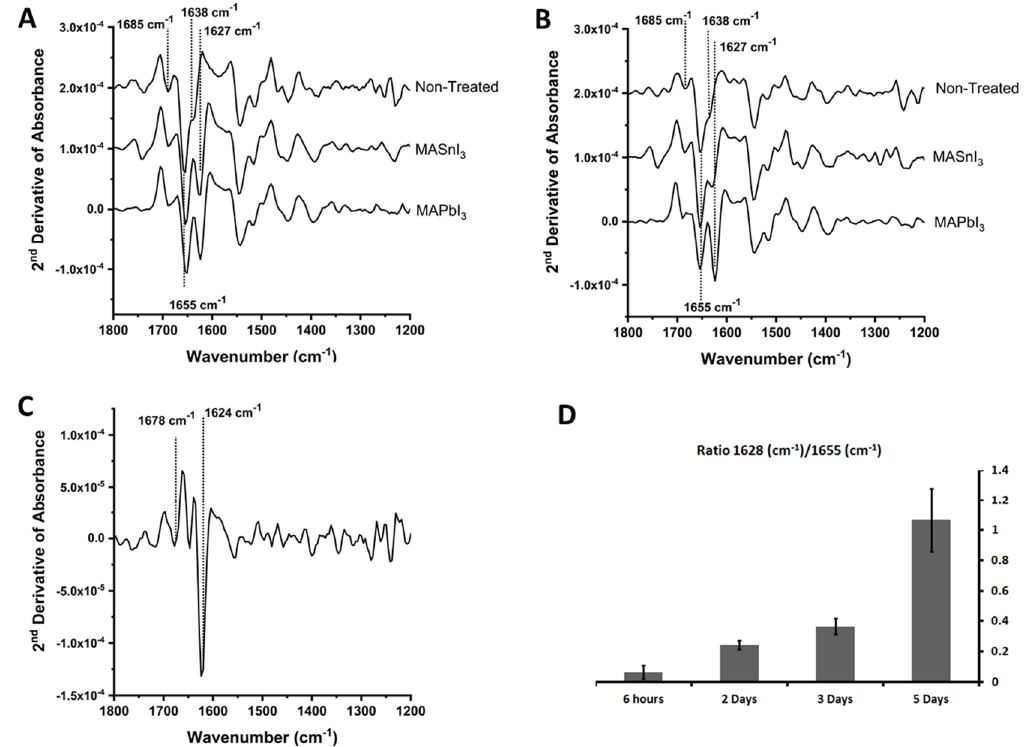
Figure 2. Average 2nd derivative of IR absorbance spectra of single cells in the 1200 cm − 1 –1800 cm − 1 range. ( A ) A549 cells, unexposed and after five days exposure to MAPbI 3 , MASnI 3 . ( B ) SH-SYS5 cells, unexposed and after five days exposure to MAPbI 3 and MASnI 3 . ( C ) Subtraction between the average spectrum of A549 cells, exposed and unexposed to MAPbI 3 . ( D ) Time course of the ratio of 2nd derivative absorption at 1652 cm − 1 and 1627 cm − 1 following exposure of A549 cells to MAPbI 3 , expressed as average ± σ . Figure reproduced and modified from [6] (I.B. doctoral thesis).